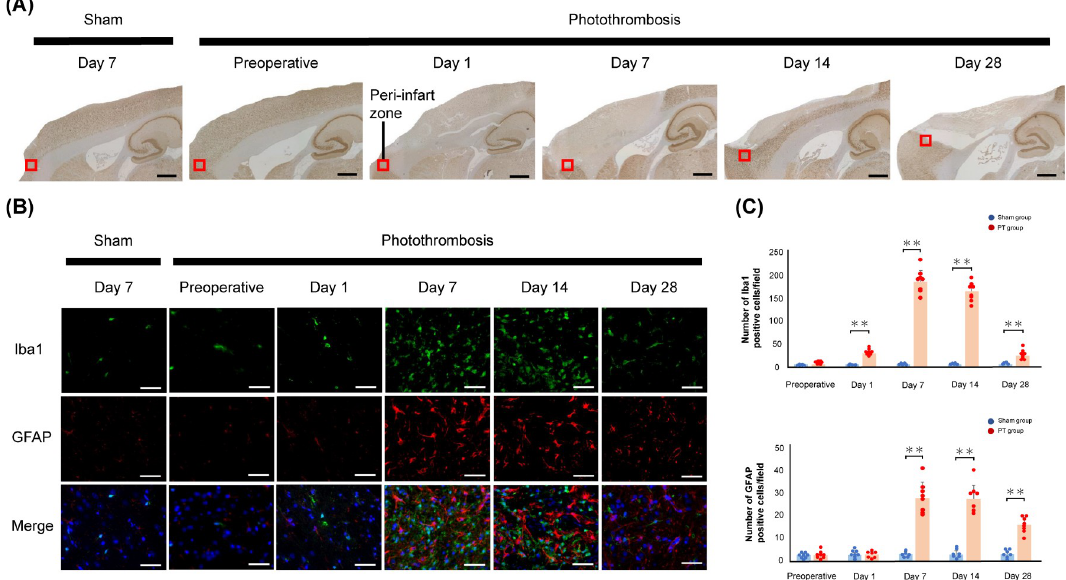
Fig 4. NeuN staining of sagittal sections and sustained activation of glial cells in ischemic regions. A: Schematic of a sagittal section (0.4 mm lateral to the midline) centered on the frontal lobe. The black square indicates the location of the peri-infarct zone. Scale bars: 1.5 mm. B: Immunofluorescence staining revealed activated microglia labeled with anti-ionized calcium binding adaptor molecule 1 (Iba1; green), reactive astrocytes labeled with anti-glial fibrillary acidic protein (GFAP; red), and nuclei labeled with 4’,6-diamidino-2-phenylindole (DAPI; blue) in the ischemic regions after photothrombosis. Scale bar = 50 μ m. C: Quantification of Iba1-positive and GFAP-positive cells. Significant differences between the photothrombosis (PT) group and sham group are indicated by �� (P < 0.01, Student’s t-test). Values are represented in mean ± SD.